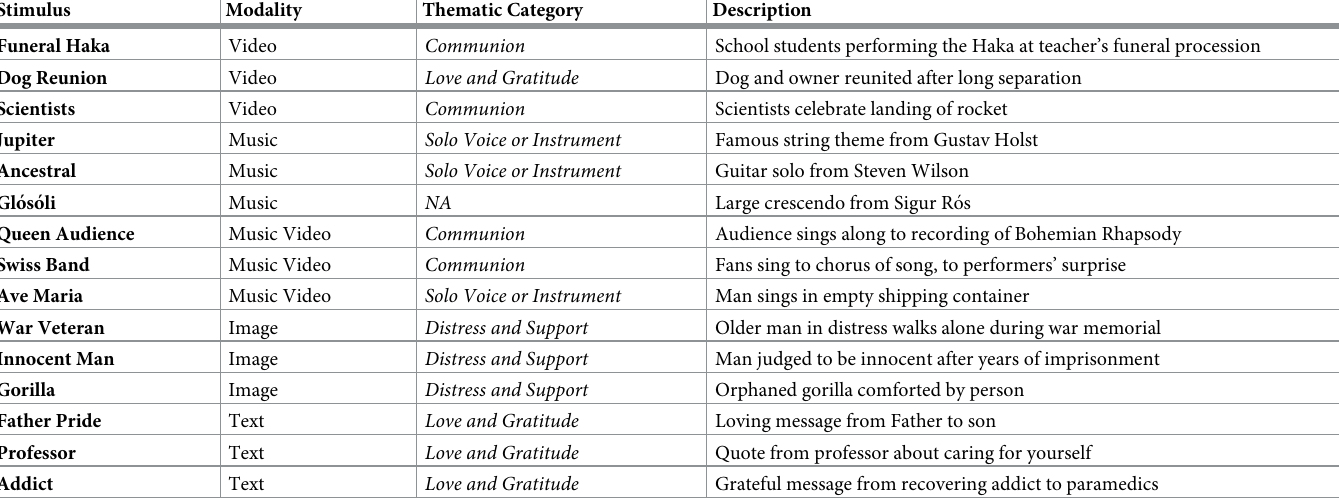
Table 1. The 15 stimuli used in the study; the thematic category labels are derived from a data-driven, agglomerative hierarchical cluster analysis (see Data Analysis and Results sections).